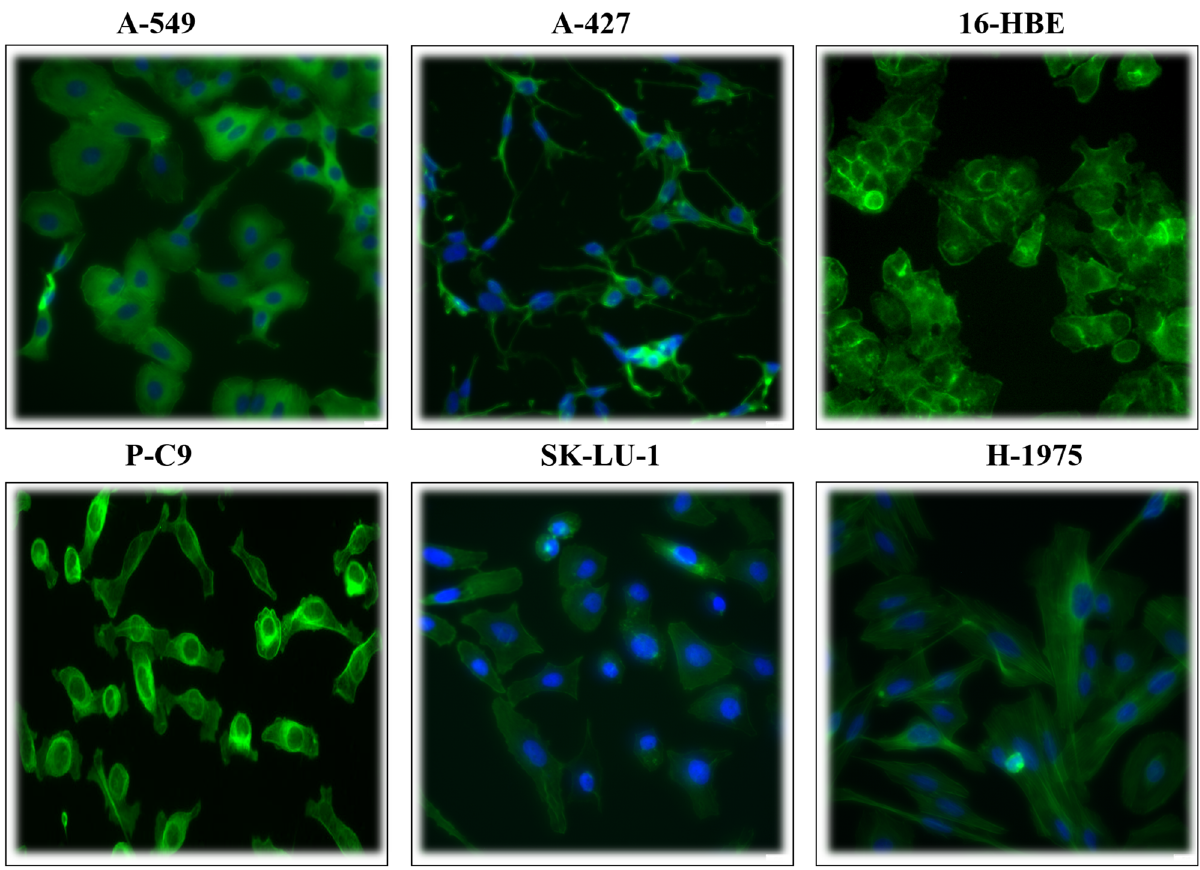
Figure 2. Representative fluorescence microscopic images of lung cell-lines (normal and five cell-lines) from our collected